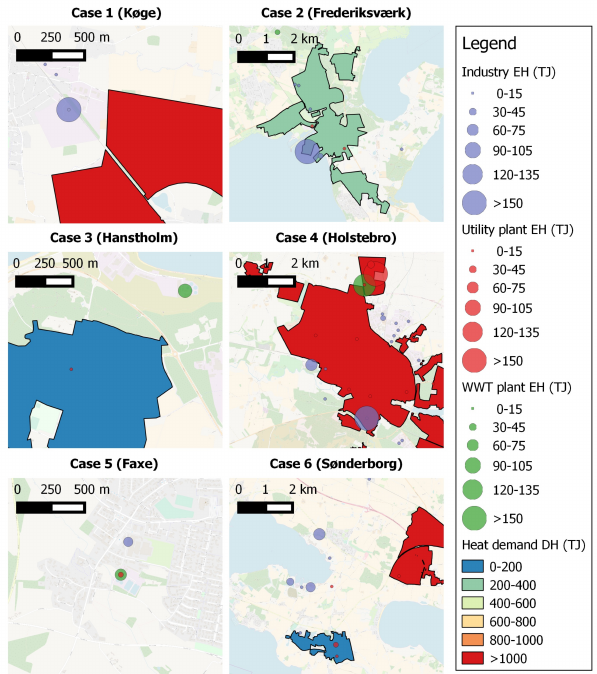
Figure 4. Examples of the identified case studies based on the overall mapping. The maps show excess heat sources as points with the radius of the points proportional to the annual excess heat. The locations of district heating areas are marked as polygons with the color representing the annual heating